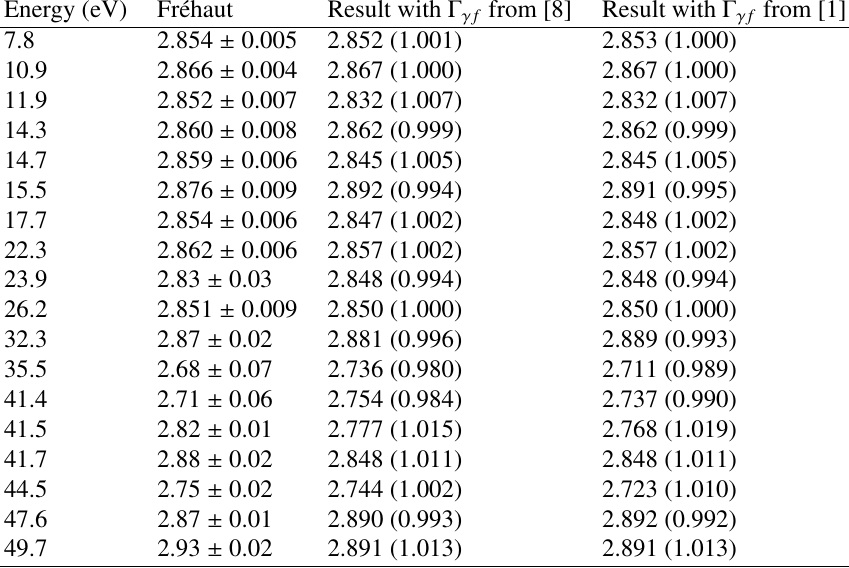
Table 3. Prompt neutron multiplicity obtained using both values for Γ γ f compared with the normalized data from Fréhaut up to 50 eV. The ratio from the experimental data to the results are given in